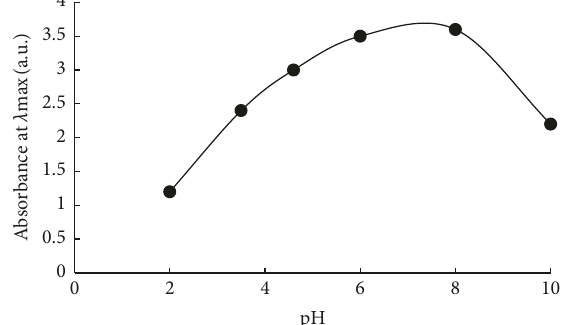
Figure 4: The effect of pH on the formation of AgNPs using plasmochemically obtained OrPWE ( S (Ag + ) � 1.0mmol/L, τ � 10min, and ratio AgNO 3 :extract (mL) � 1